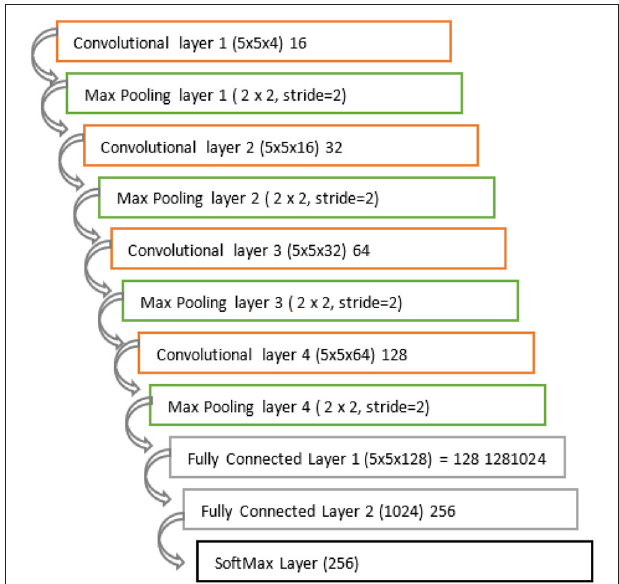
FIGURE 9 | CNN model layers.